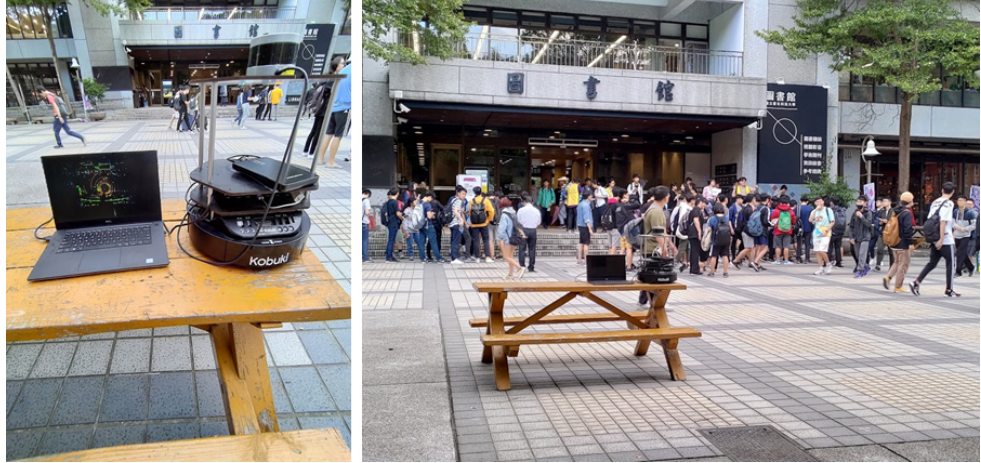
Figure 1. The setup of the Velodye LiDAR